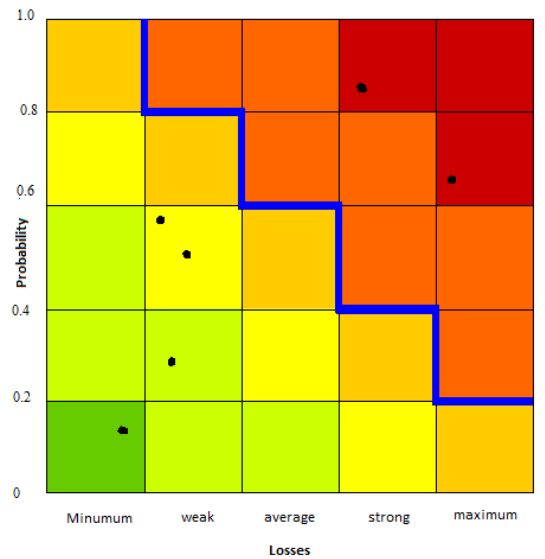
Figure 2. Risk Map. (Dots on the Risk Map indicate the location of risks of M&A in coordinates: Probability—Losses.)